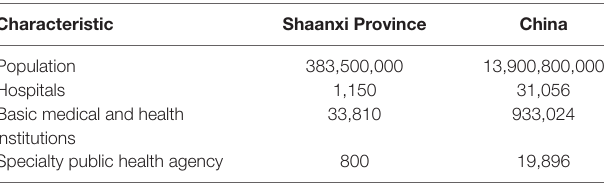
TABLE 1 | Comparative characteristics of Shaanxi Province and the whole country, China,